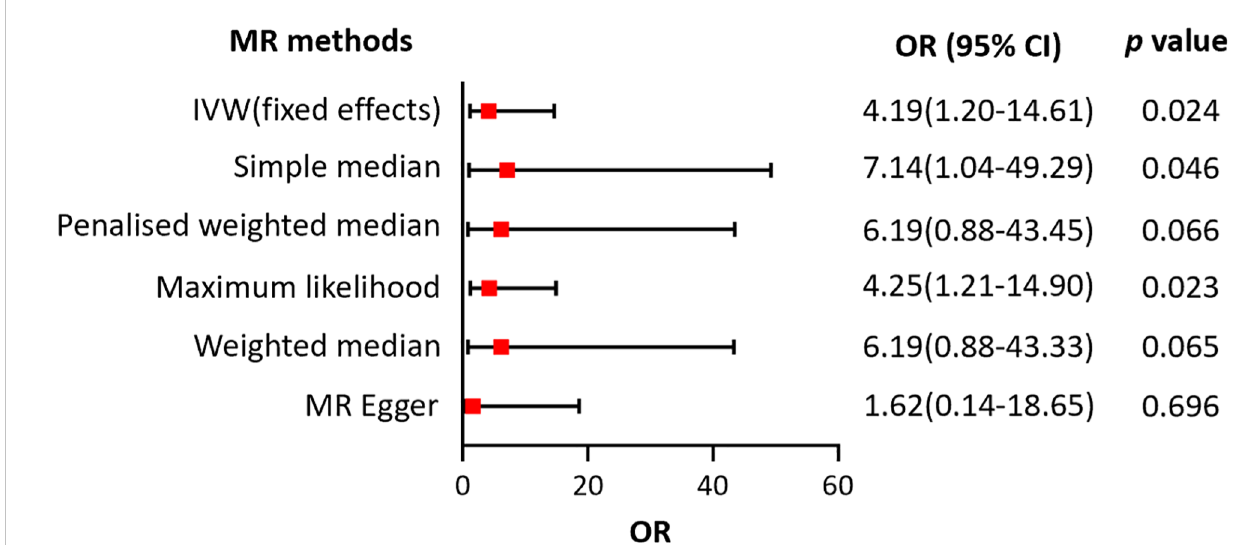
FIGURE 4 Forest plot of the association between genetically predicted telomere length and androgenetic alopecia. OR refers to the change of alopecia risk associated with a one standard deviation (SD) decrease in telomere length. IVW , inverse variance weighted; OR , odds ratio; CI , con fi dence interval.